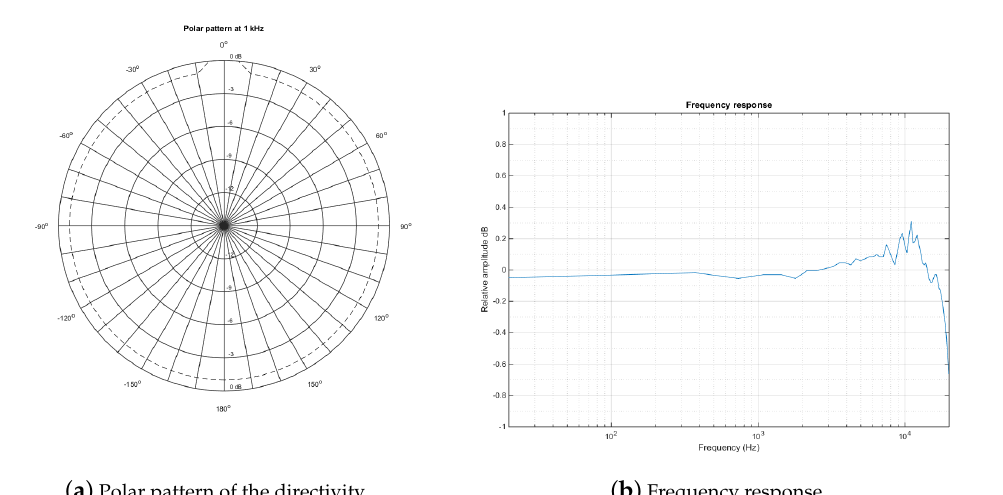
Figure 4. Characteristics of the selected microphone, T-Bone GC100.